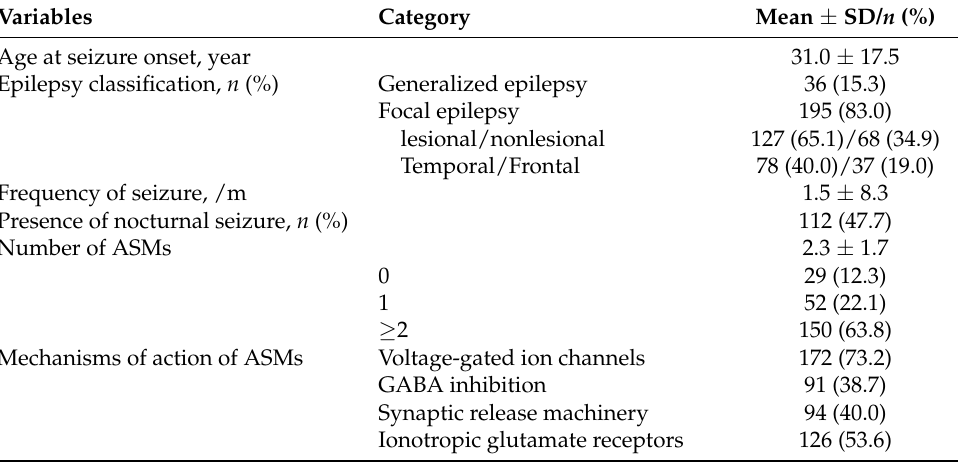
Table 2. Epilepsy-related factors in patients with obstructive sleep apnea and